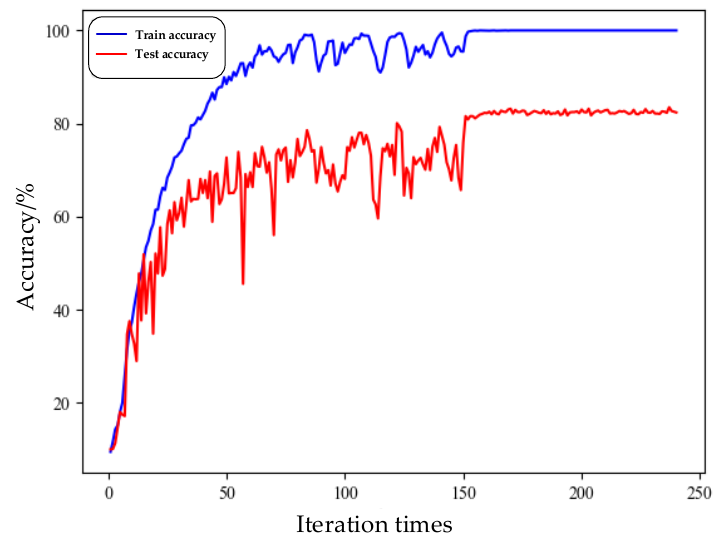
Figure 9. Training set and validation set accuracy of knowledge distillation network training.